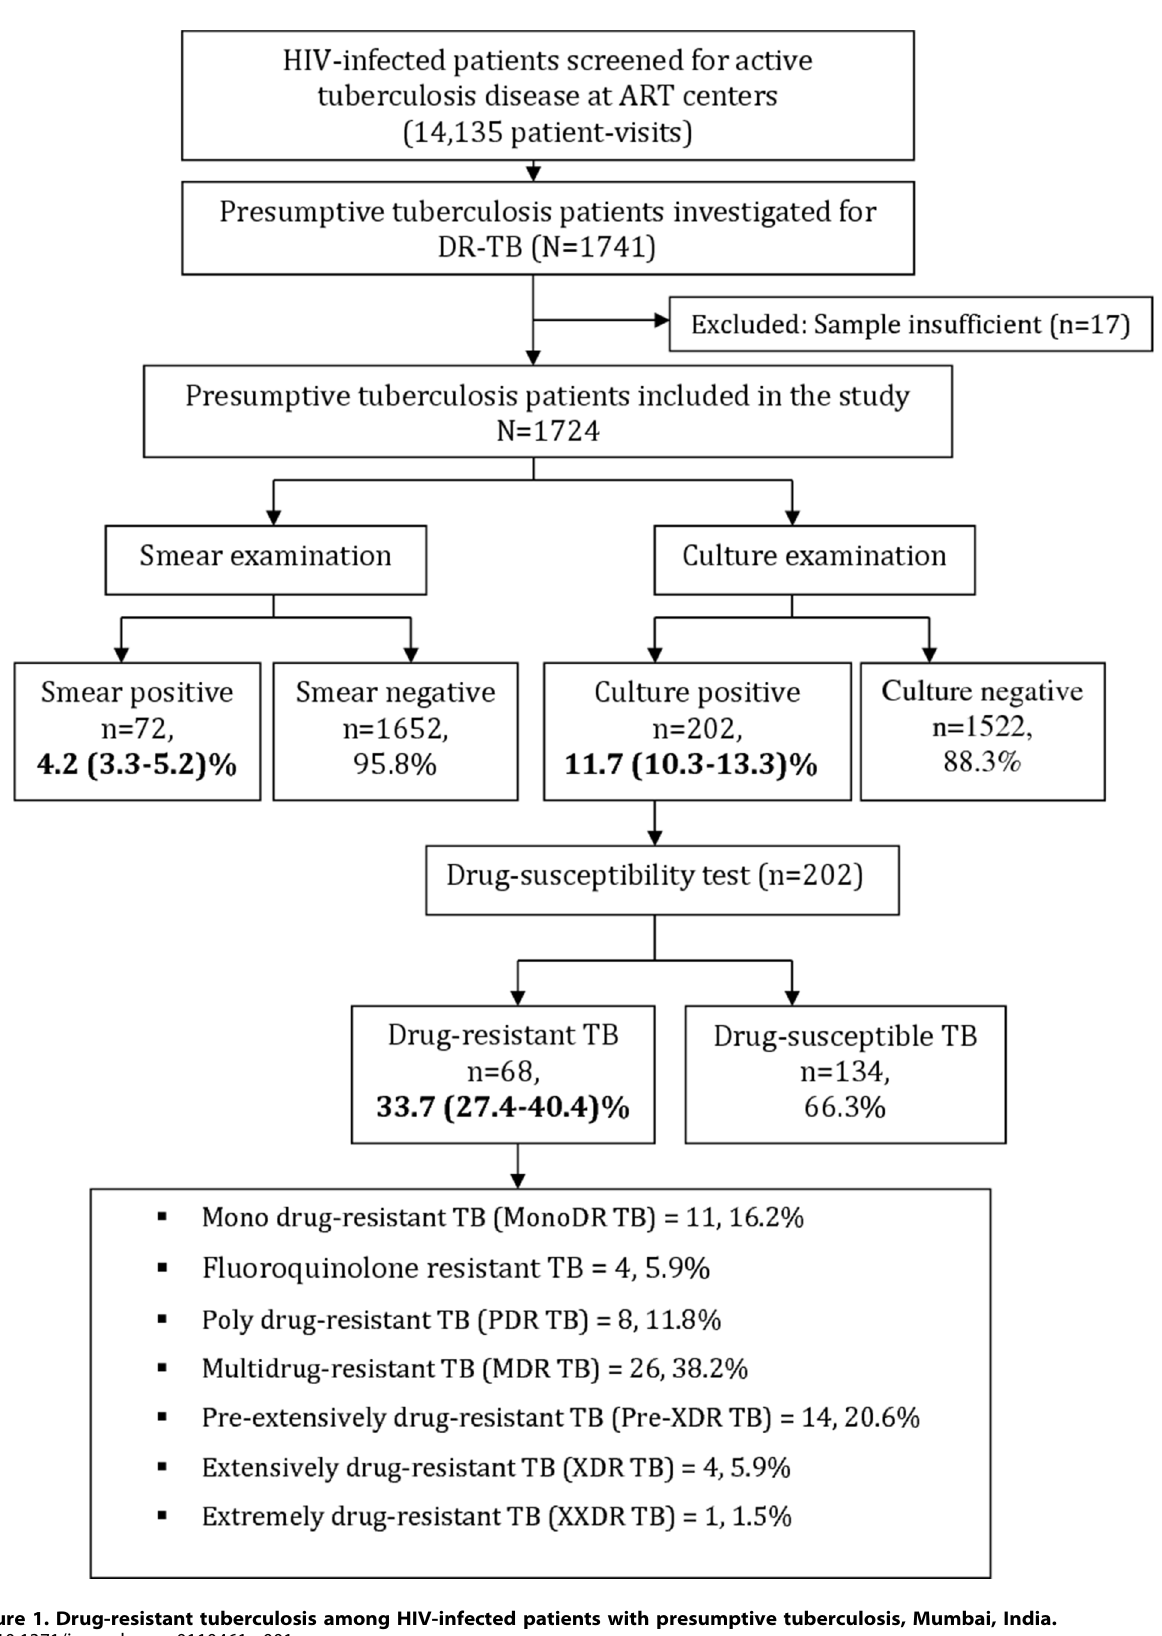
Figure 1. Drug-resistant tuberculosis among HIV-infected patients with presumptive tuberculosis, Mumbai, India.